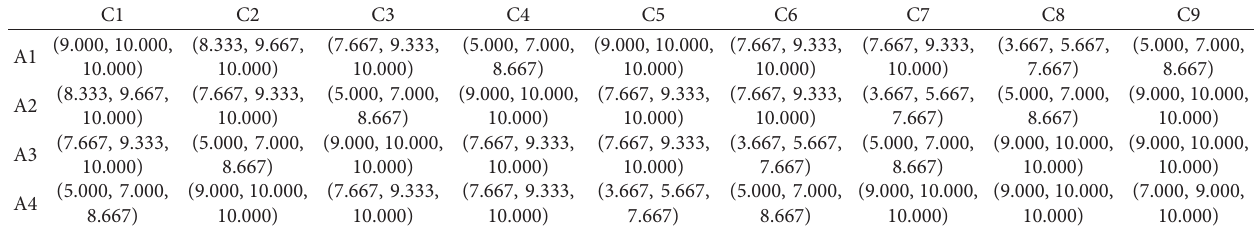
Table 11: Fuzzy decision matrix 􏽥 D